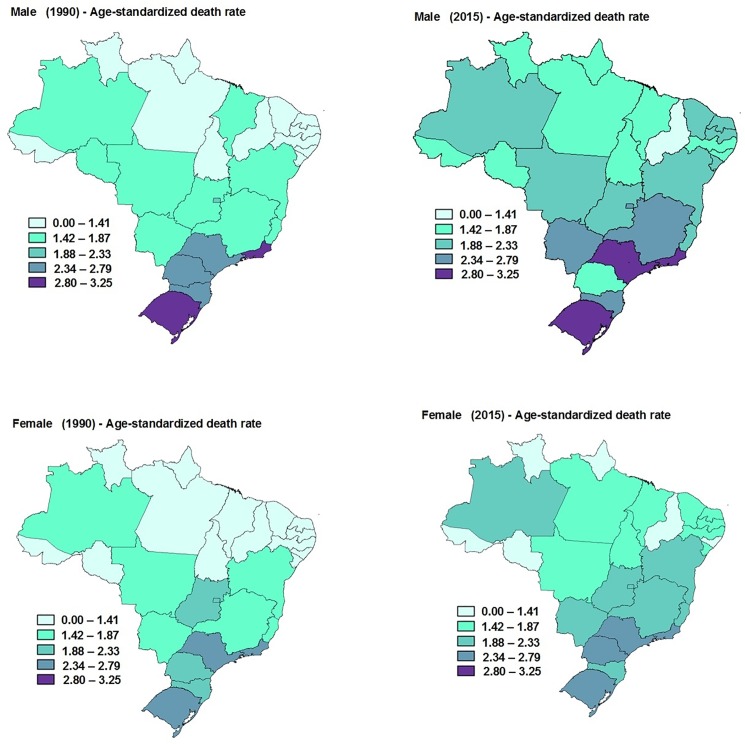
Age-standardized death rate (per 100,000 inhabitants) from colorectal cancer due to physical inactivity in males and females in the Brazilian states.